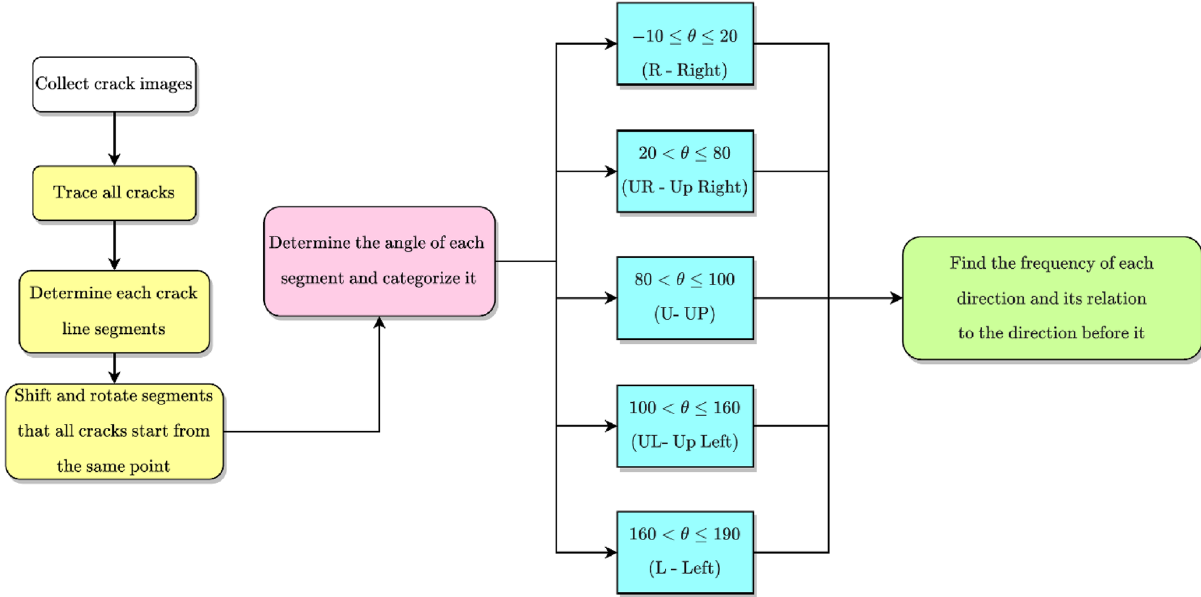
Figure 5. Flowchart of the developed crack tracing and analysis algorithm.